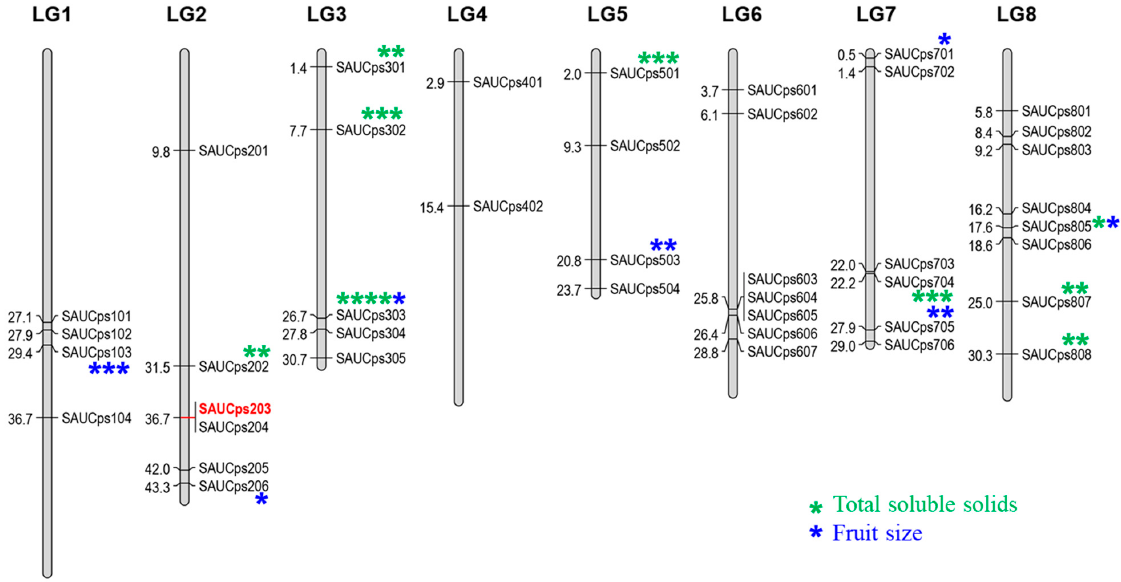
Figure 2. Graphical distribution of new SSR markers among linkage groups of Chinese cherry. SAUCps203 represents the SSR markers with species-specificity. (*: p < 0.01; **: p < 0.005; ***: p < 0.002; ****: p < 0.001).